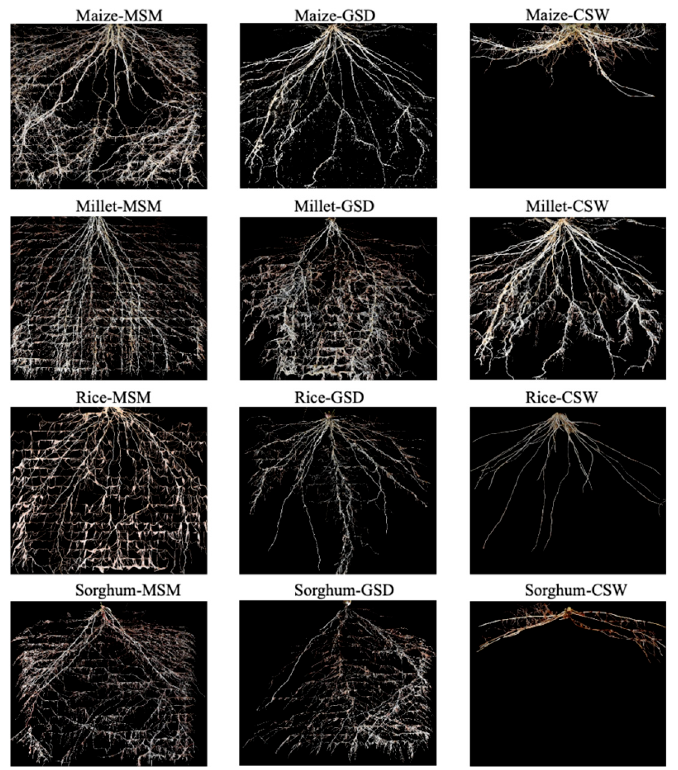
Figure 2. Representative two ‐ dimensional root images of maize, millet, rice, and sorghum grown under moderate soil moistures (MSM), gradual drying soil (GSD), and continuous waterlogging (CSW) for 25 days after treatment.